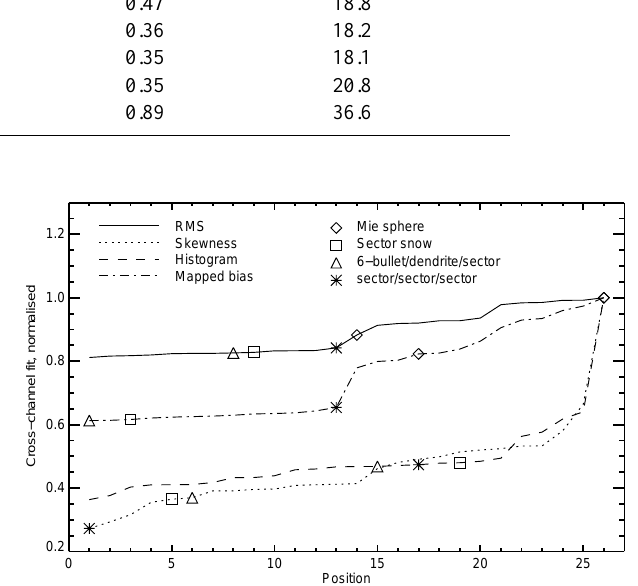
Figure 9. Measures of fit in the fine search, averaged across all channels, ranked from best (1) to worst (26) and then normalised so that the worst equals one. The positions of a few important ex- periments are identified by